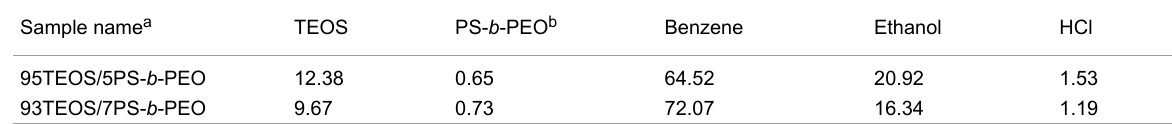
Table 2: Compositions (wt %) of micellar